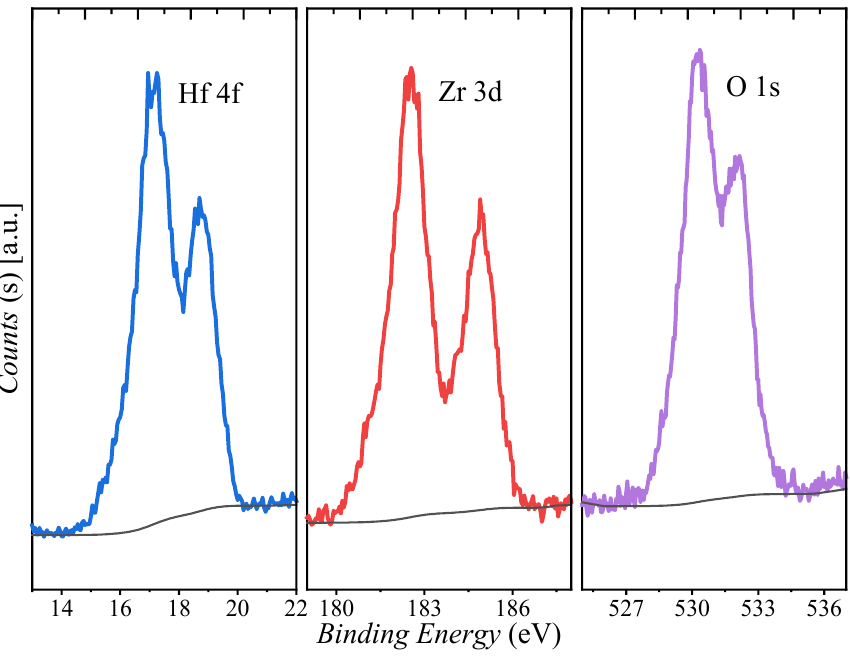
Figure 3. The XPS survey scan of the deposited 8.5 nm HZO layer.